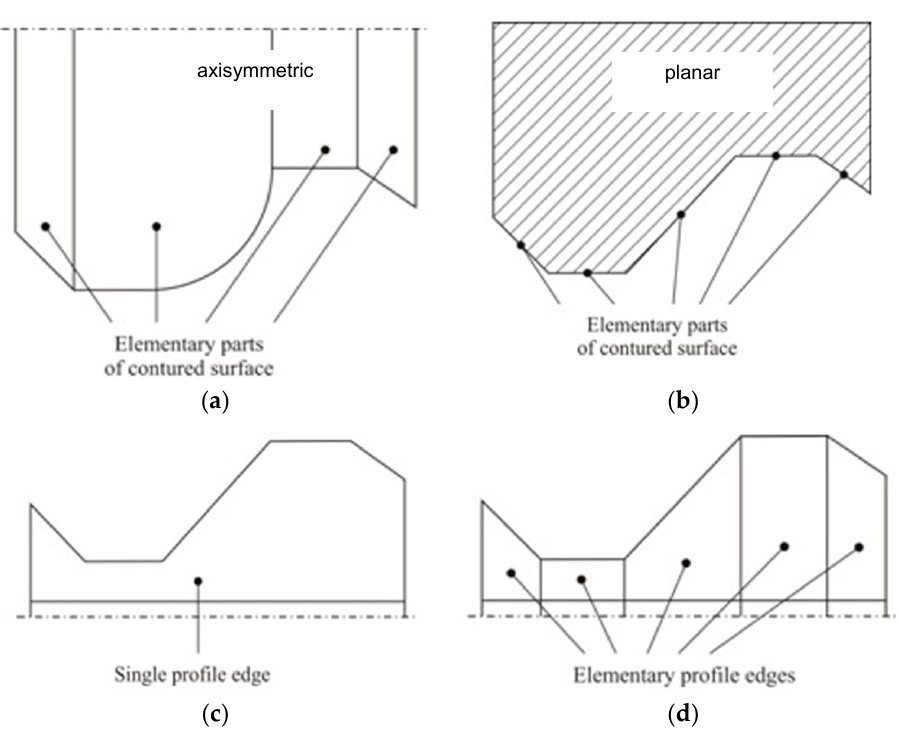
Figure 1. An example of ( a ) an axisymmetric contoured surface, ( b ) a planar contoured surface, ( c ) a single edge profile, ( d ) a profile combining from another multi-insert.